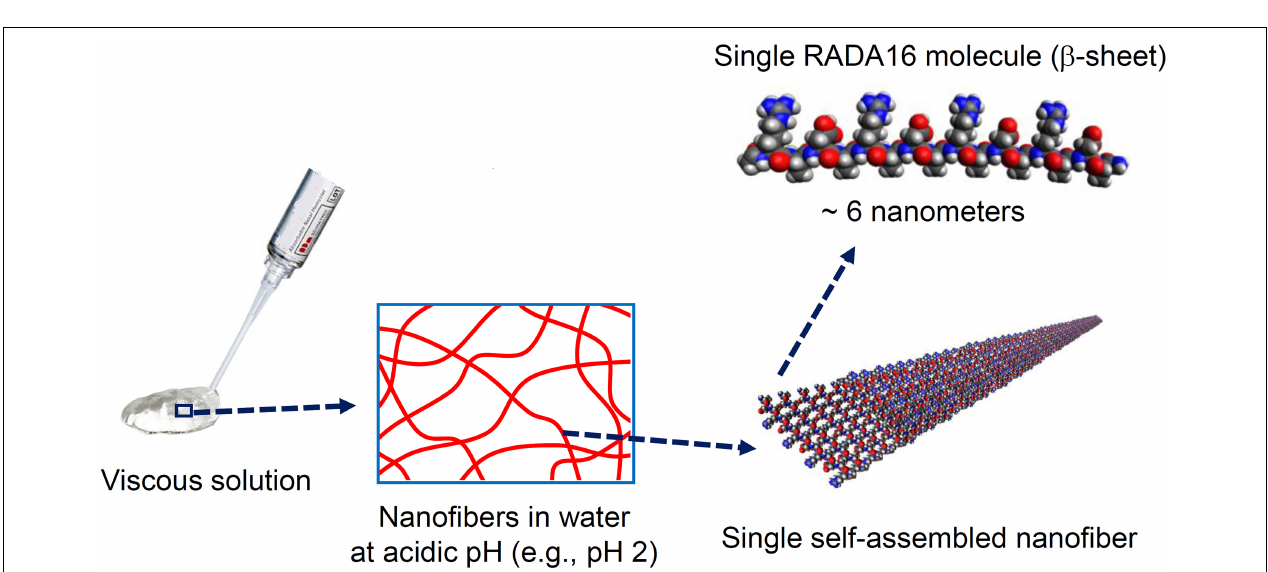
FIGURE 1 | Chemical structure of RADA16 peptide. RADA16 peptide chemical structure showing the 16 amino acids organized as sequentially repeated 4-amino acid sequences containing R (positively charged arginine), A (hydrophobic alanine), and D (negatively charged aspartic acid) residues.